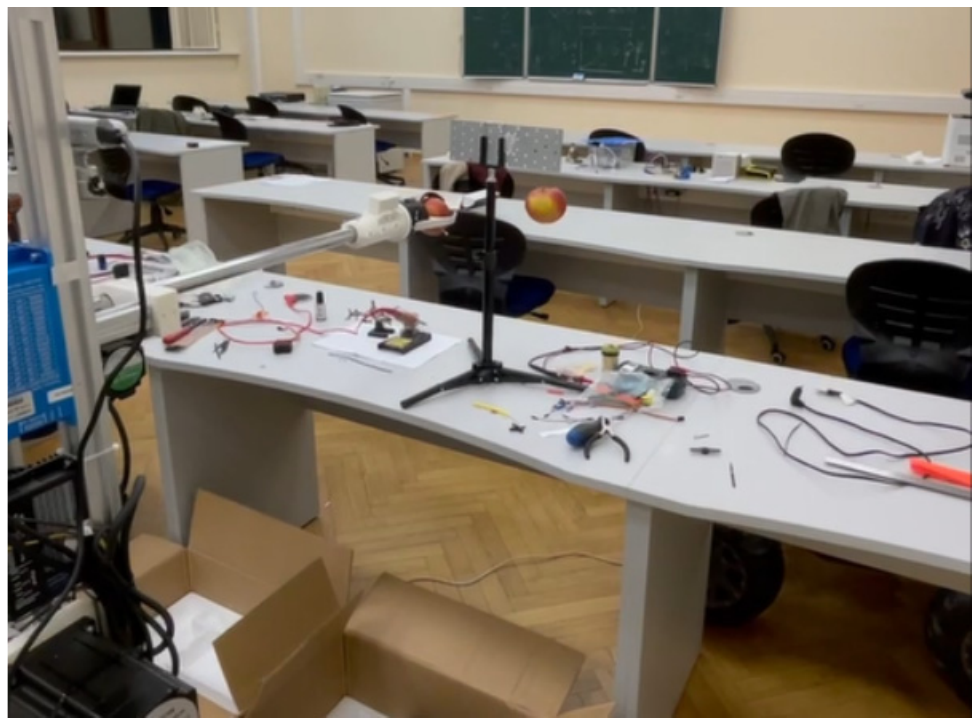
Figure 10. Apple grabbing.